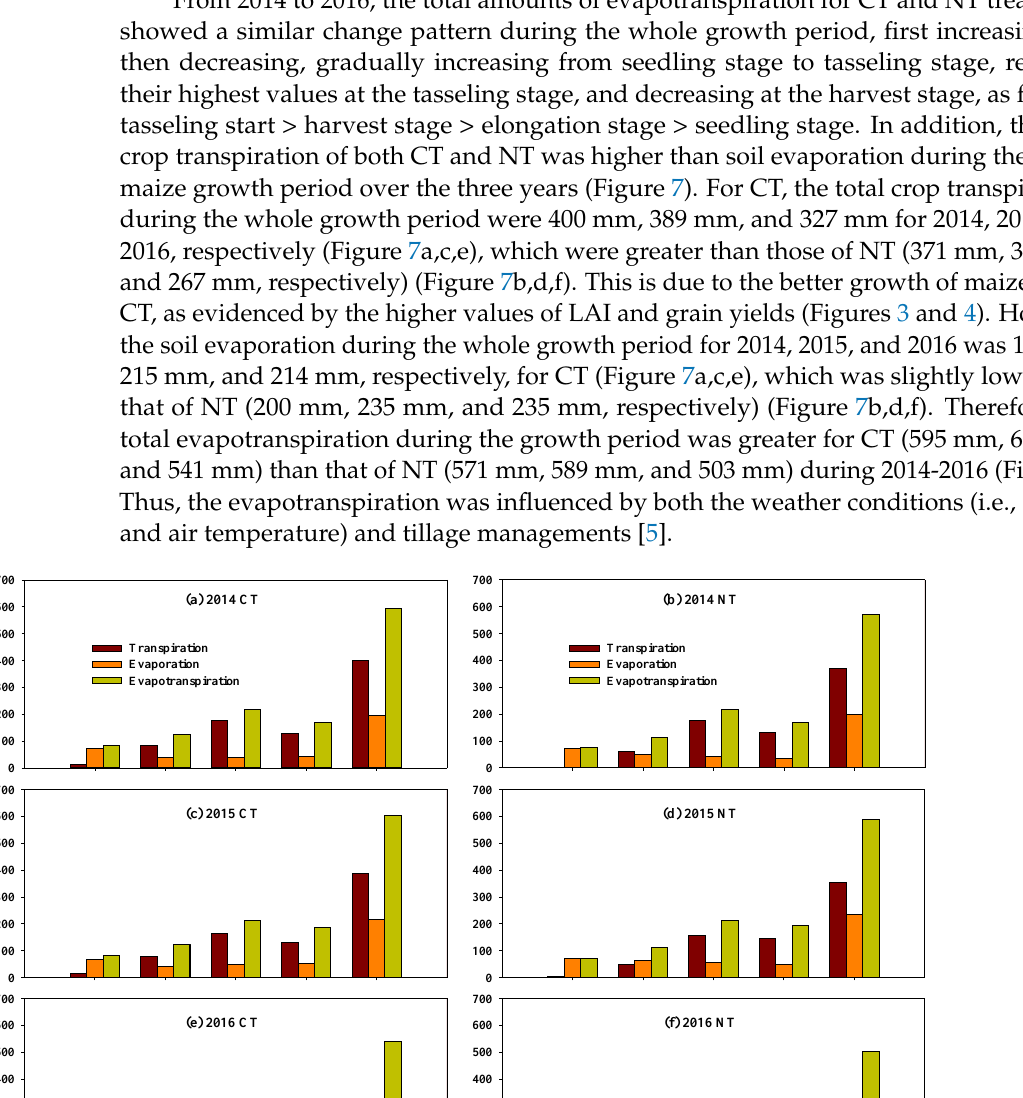
At the seedling stage of maize, the crop dry-matter accumulation (CWAD) was sig- nificantly positively correlated with crop transpiration (EPAA), with a correlation coeffi- cient of 0.784 ( p < 0.01), and negatively correlated with soil water content (SWTD), with a correlation coefficient of ‒0.198 ( p < 0.01), and there was a significant negative correlation between EPAA and SWTD, with a correlation coefficient of 0.237 ( p < 0.01) (Table 3). At the jointing stage of maize, there was a significant positive correlation between CWAD and EPAA (correlation coefficient of ‒0.296). At the tasseling stage, SWTD was signifi- cantly positively (r = 0.138, p < 0.05) correlated with CWAD, but significantly negatively (r = ‒0.219, p < 0.01) correlated with EPAA. During the harvest period, the CWAD was significantly negatively correlated with EPAA (r = ‒0.396, p < 0.01), but significantly posi- tively ( p < 0.01) correlated with SWTD and GWAD (r = 0.332 and r = 0.465, respectively), and there was a significant negative correlation between GWAD and EPAA (r = ‒0.679, p < 0.01) (Table 3). The SWTD was generally negatively correlated with EPAA, and CWAD was generally positively correlated with EPAA and SWTD during the four stages. These results indicated that the maize yields and productions were mainly influenced by both EPAA and SWTD, e.g., the maize yields and productions increased as the SWTD and EPAA increased, to some extent.